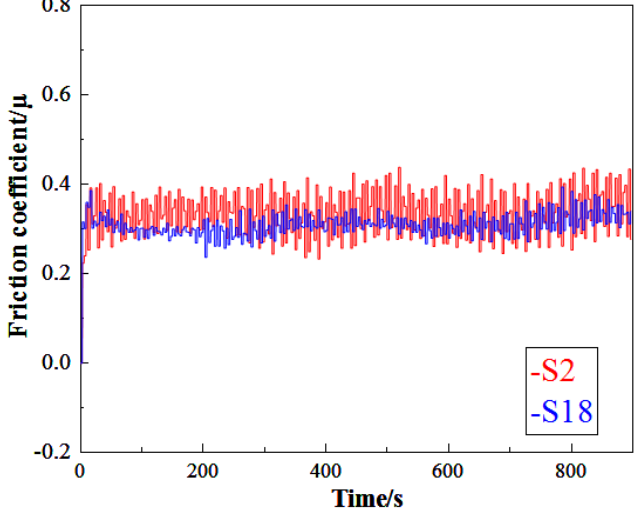
Figure 8. Friction coefficient versus wear ‐ time curve.